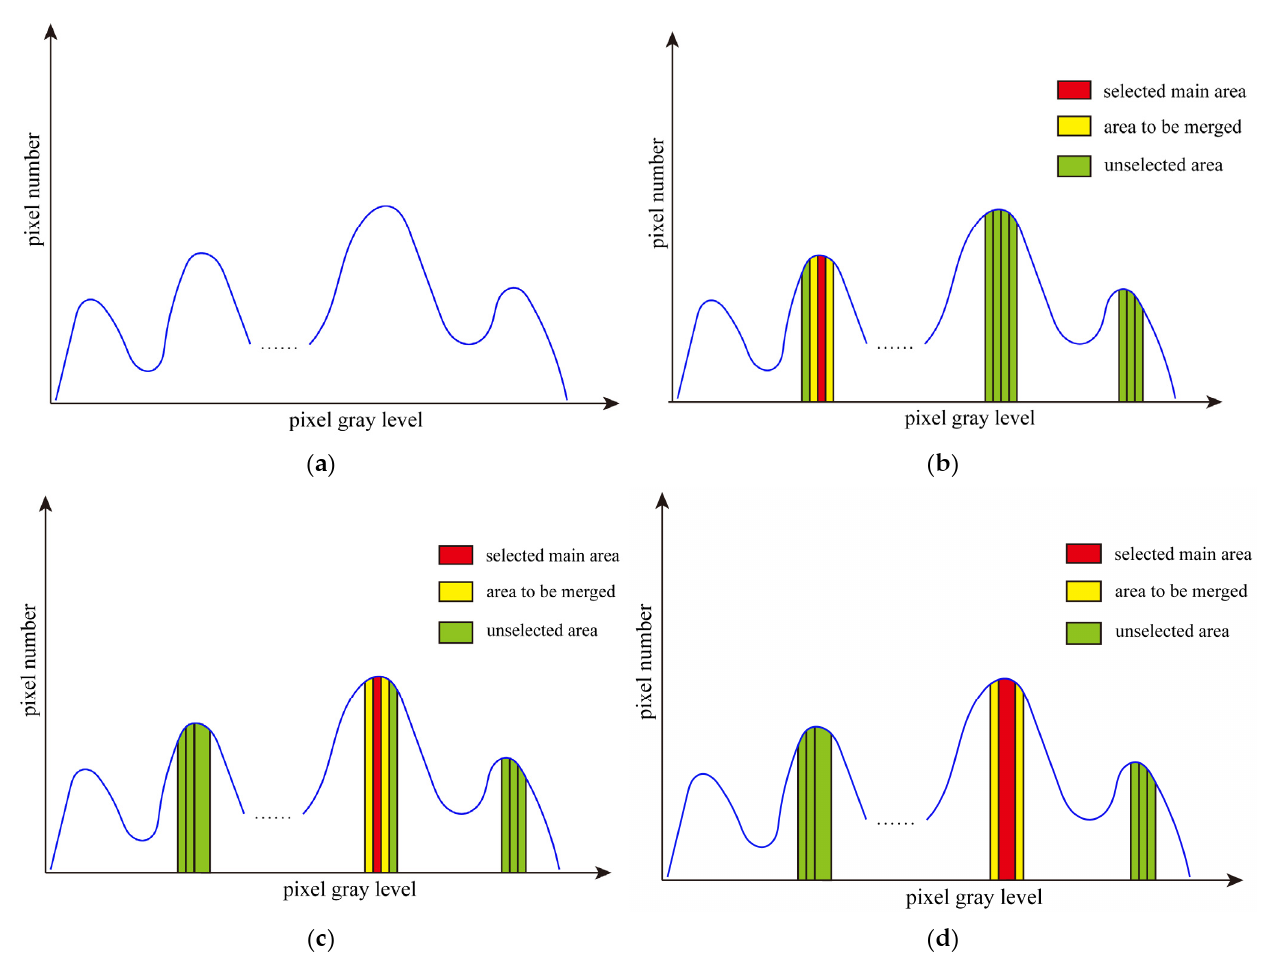
Figure 1. The grayscale histogram of the original image and the process of region growing. ( a ) Image grayscale histogram, ( b ) area selection for first region growing, ( c ) results of the first area growth and selection of the main area for the second region growing, and ( d ) the second region growing results and main area selection for the next.